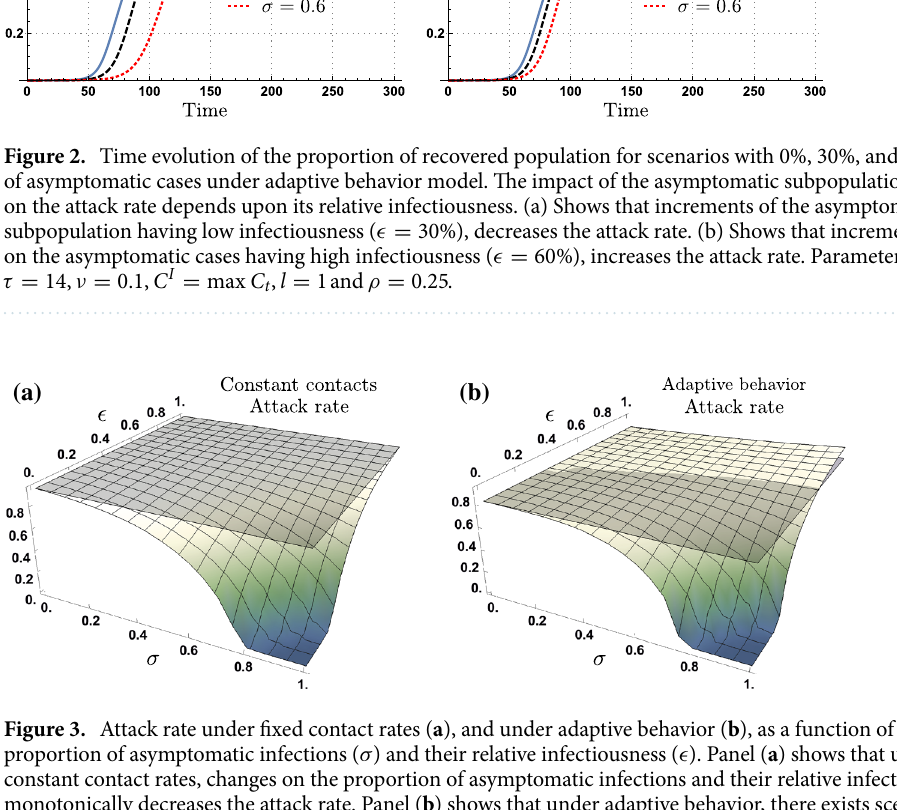
I = max C t , l = 1 and